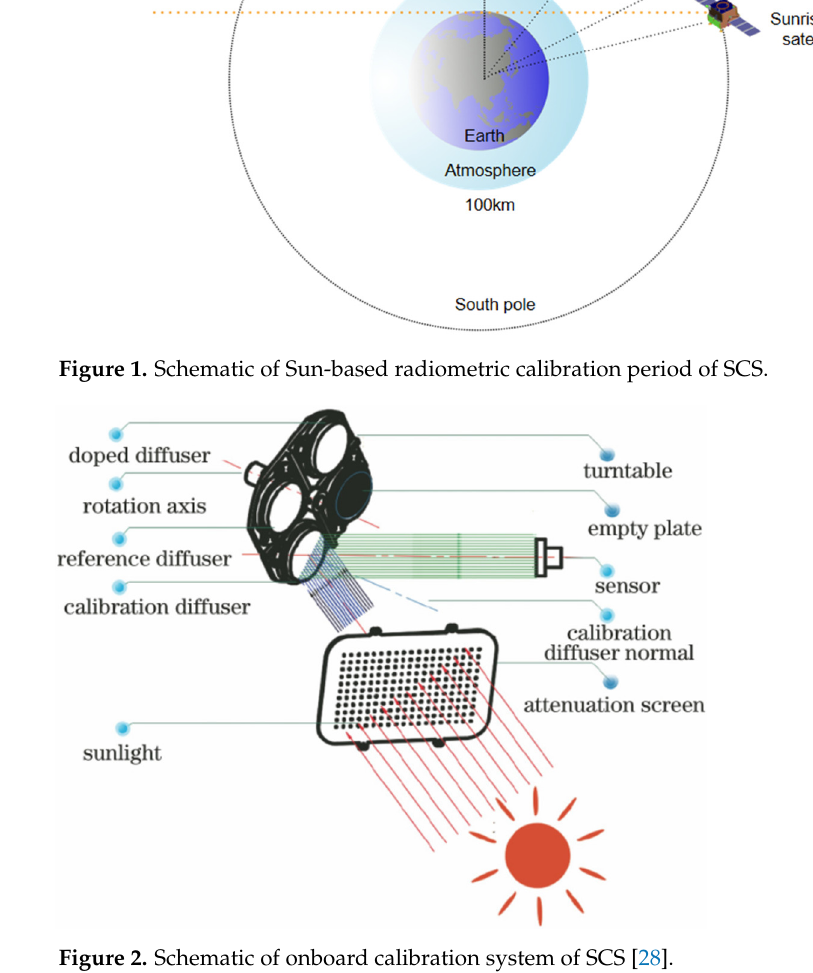
Figure 1. Schematic of Sun-based radiometric calibration period of SCS.